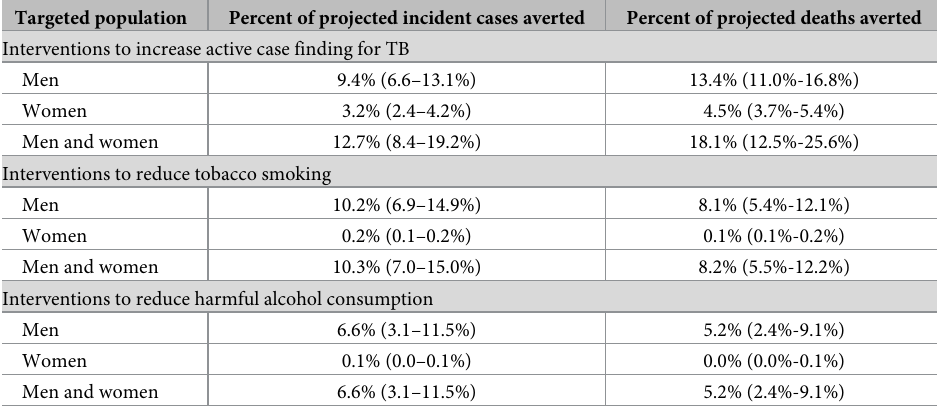
Table 1. Percent of projected incident cases averted and deaths averted over 2021–2035 for interventions to increase active case finding for TB, to reduce tobacco smoking, and to reduce harmful alcohol consumption by target